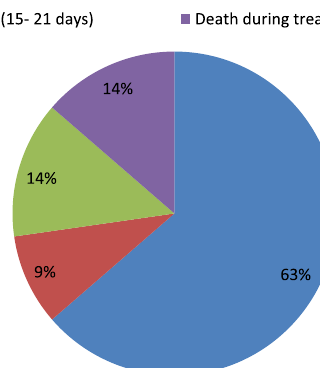
Fig. 2 Time of death after vaccination/ presentation/admission/intervention along with number of deaths during that time